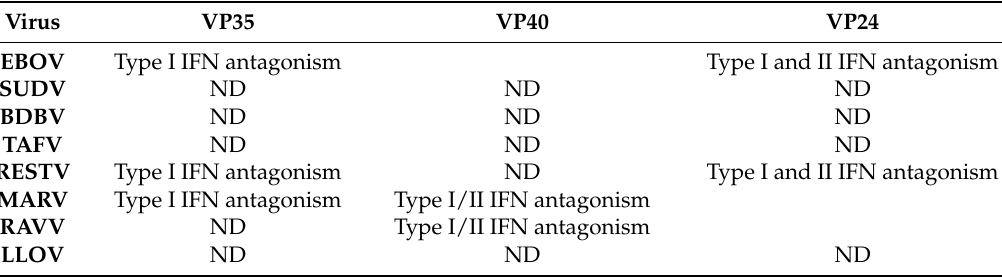
Table 3. Type I IFN inhibition by